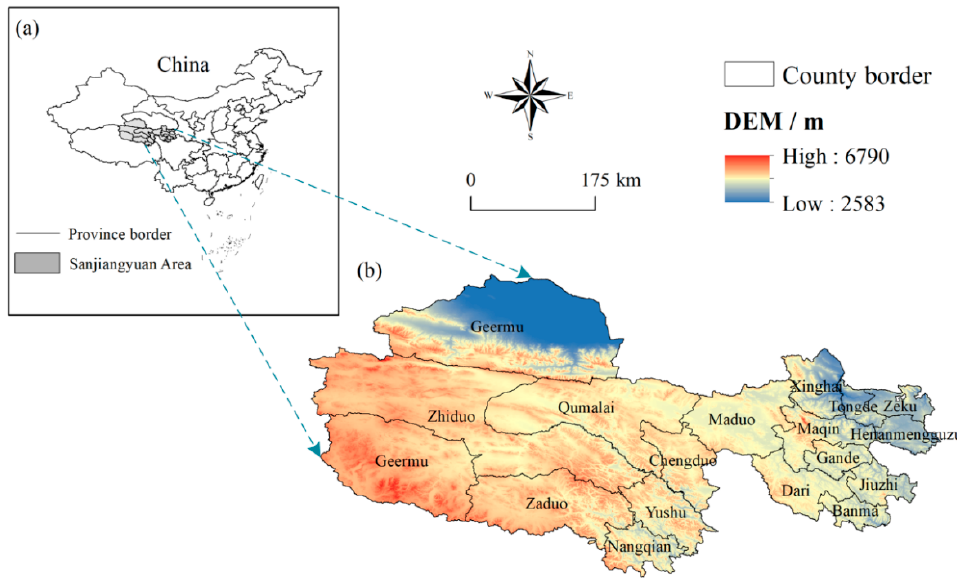
Figure 1. Map of the study area (( a ): overview; ( b ): DEM, digital elevation model).